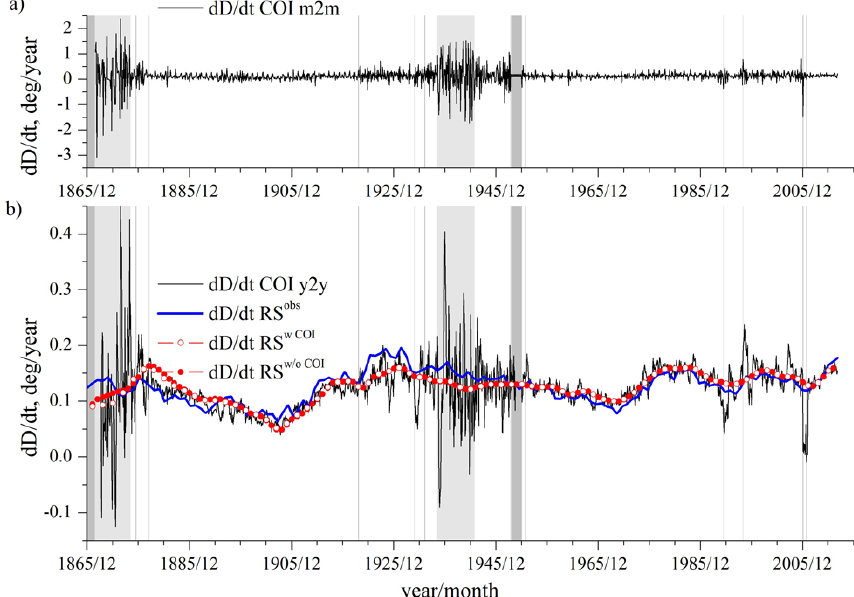
Fig. 10. (a) Month-to-month derivative (m2m d D/ d t ) of COI D series. (b) Year-to-year derivative (y2y d D/ d t ) of COI D series (thin black line) together with first derivatives of RS obs – D (thick blue line), RS w COI -D and RS w/o COI – D (red line with open and filled circles, respectively). Vertical lines mark periods of possible homogeneity breaks for COI data (see Table